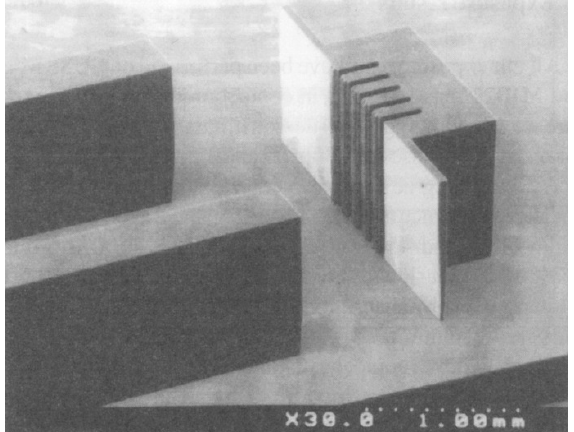
Figure 1. SEM (scanning electron microscope) image of 1200 µm-thick structures in SU-8 with a linewidth of 65 µm, resulting in an aspect ratio of 18 (double-spin coated). From [6], © 1997